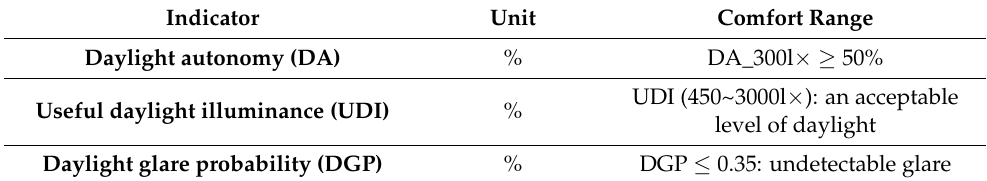
Table 3. Interior light environment evaluation indicators and comfort ranges (self-developed).